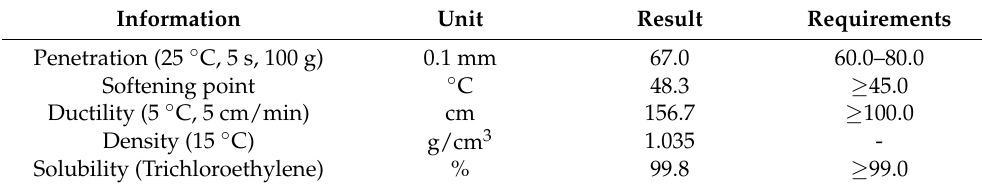
Table 2. Chemical composition of SSP.